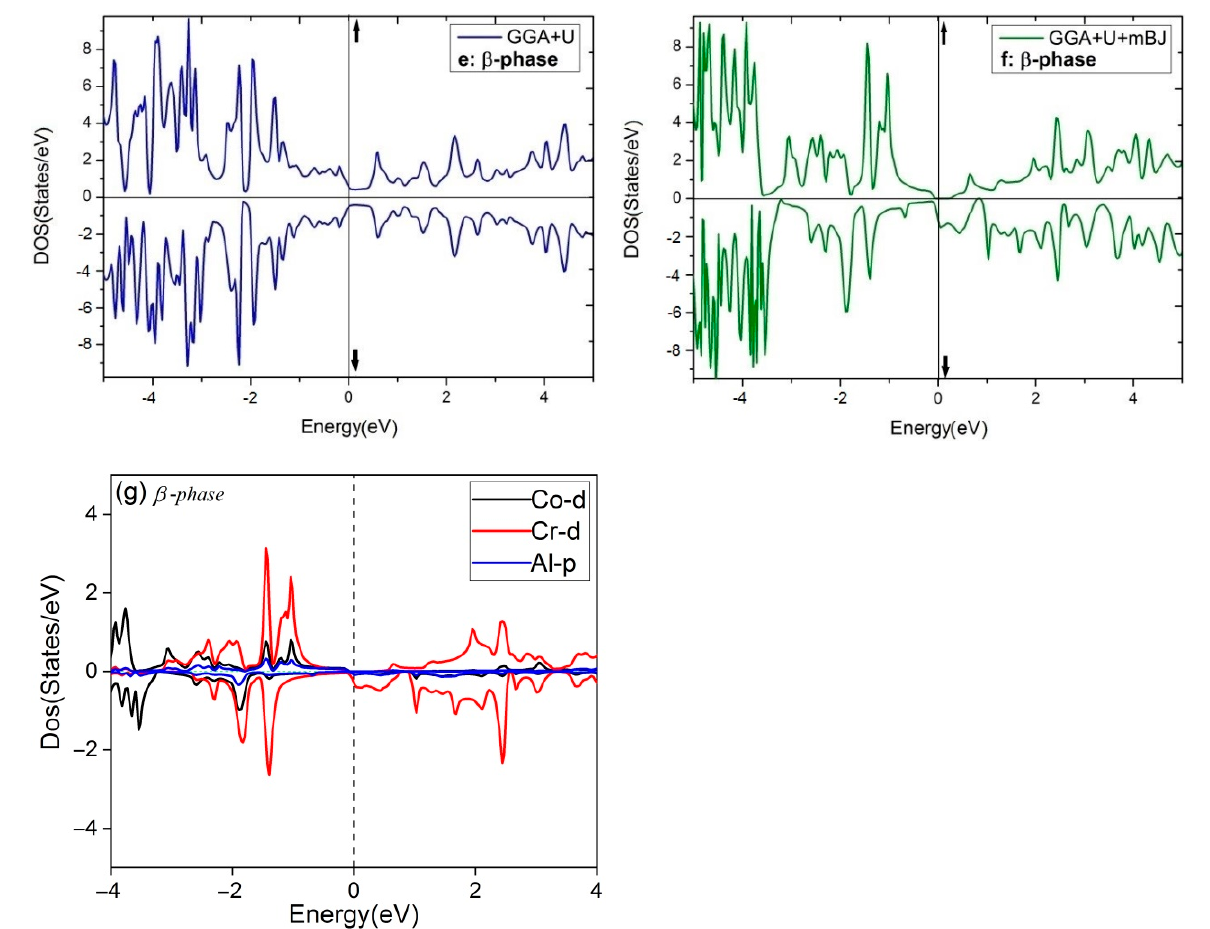
Figure 5. The total DOS of four phases of Co 2 CrAl for three different approximations: ( a ) Bulk phase, ( b ) α phase, ( c ) γ phase, ( d ) β phase by GGA, ( e ) β phase by GGA+U, ( f ) β phase by GGA+U+mBJ, and ( g ) The Partial DOS of β phase by GGA+U+mBJ.